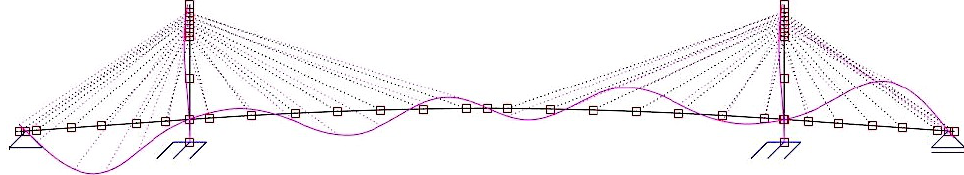
Figure 4. Mode shape No. 6.